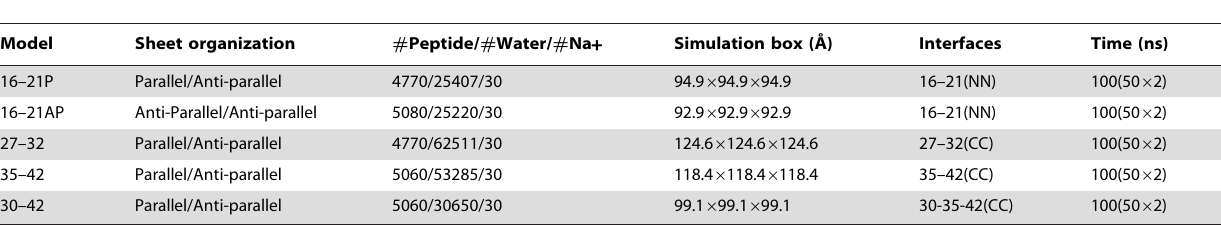
Table 1. Summary of A b segmental polymorphic oligomeric models and Simulation Conditions.